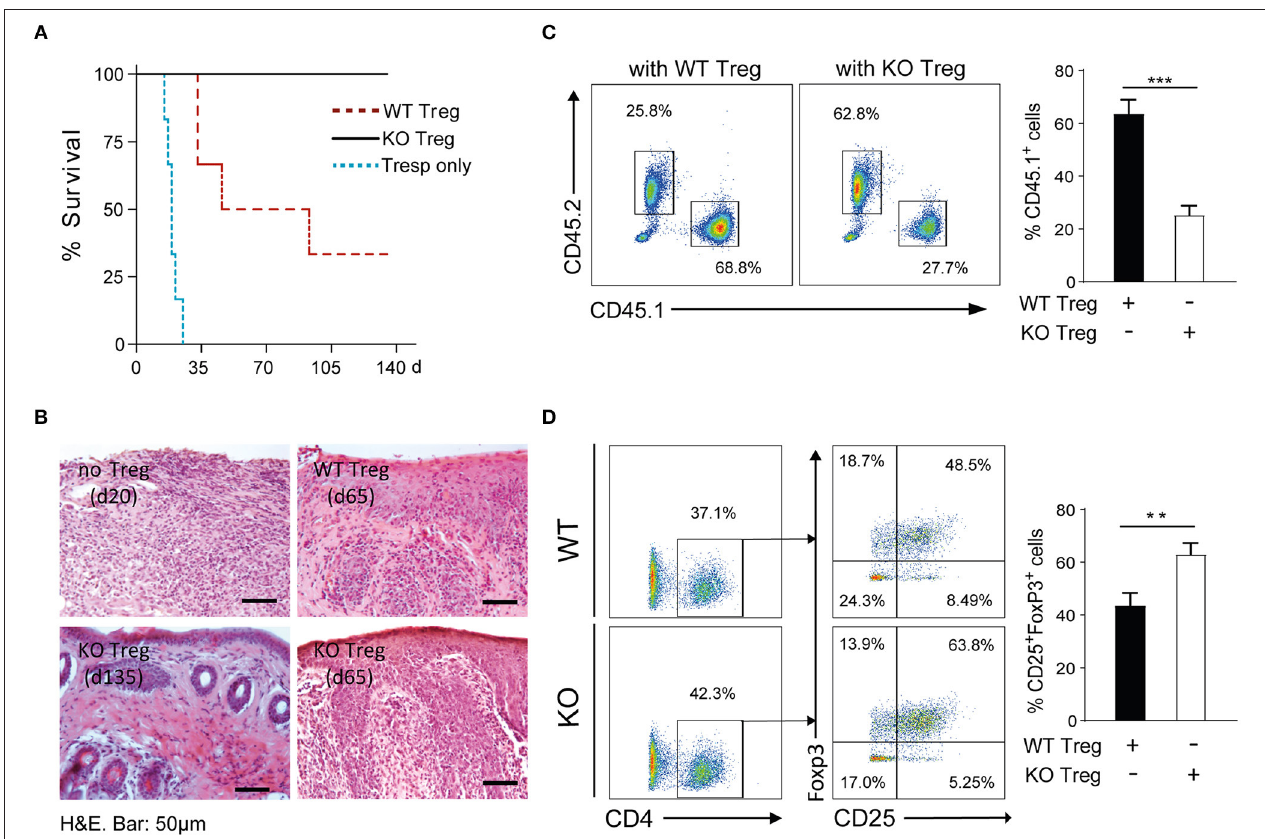
FIGURE 5 | PAR4ko Tregs promote indefinite skin allograft survival in vivo . BALB/c skin graft survival was assessed in recipients Rag2 − / − mice in which CD45.1 + Tresps only (blue dotted line, n = 6) or at a ratio 2 to 1 with CD45.2 + WT (red dotted line, n = 6) or PAR4ko (black solid line, n = 6) Tregs were adoptively transferred. (A) Survival graph of skin allografts. Data were analyzed by Log-rank test. p = 0.0005, when Tresps with WT (or PAR4ko) Tregs were compared to Tresps only groups; p = 0.0179, comparison between WT and PAR4ko Treg groups. (B) Representative H&E staining of skin grafts from recipient mice receiving Tresps only (day 20) or Tresps with WT or PAR4ko Tregs (d65), or from Tresps with PAR4ko Tregs (d135). Bar, 50 µ m. Flow cytometry analysis of CD45.1 + and CD45.2 + population (C) and the CD25 + FoxP3 + cells in the CD4 + gated population of CD45.2 + cells (D) in the draining lymph nodes of the recipients receiving WT or PAR4ko Treg cells sacrificed at d115. Graphs show mean ± SEM from four mice per group. Data were analyzed by unpaired two-way t -test. ** p < 0.01 *** p < 0.001 when WT and PAR4ko Treg groups were compared.